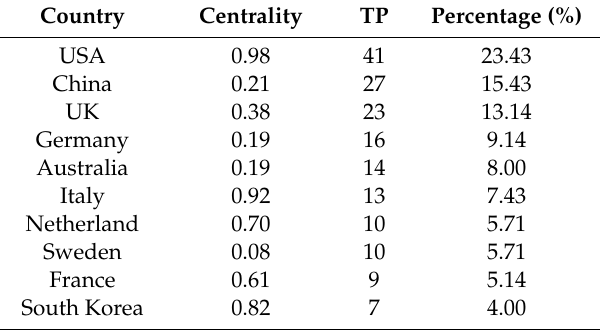
Table 2. Top 10 countries with the most published articles from 2007 to 2019. Country Centrality